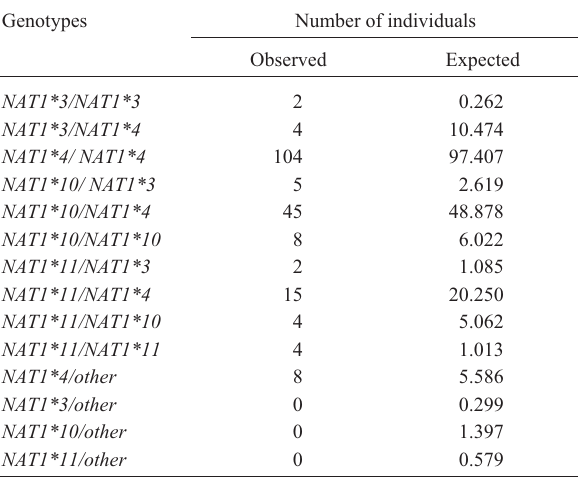
Table 1 - Distribution of observed and expected numbers of NAT1